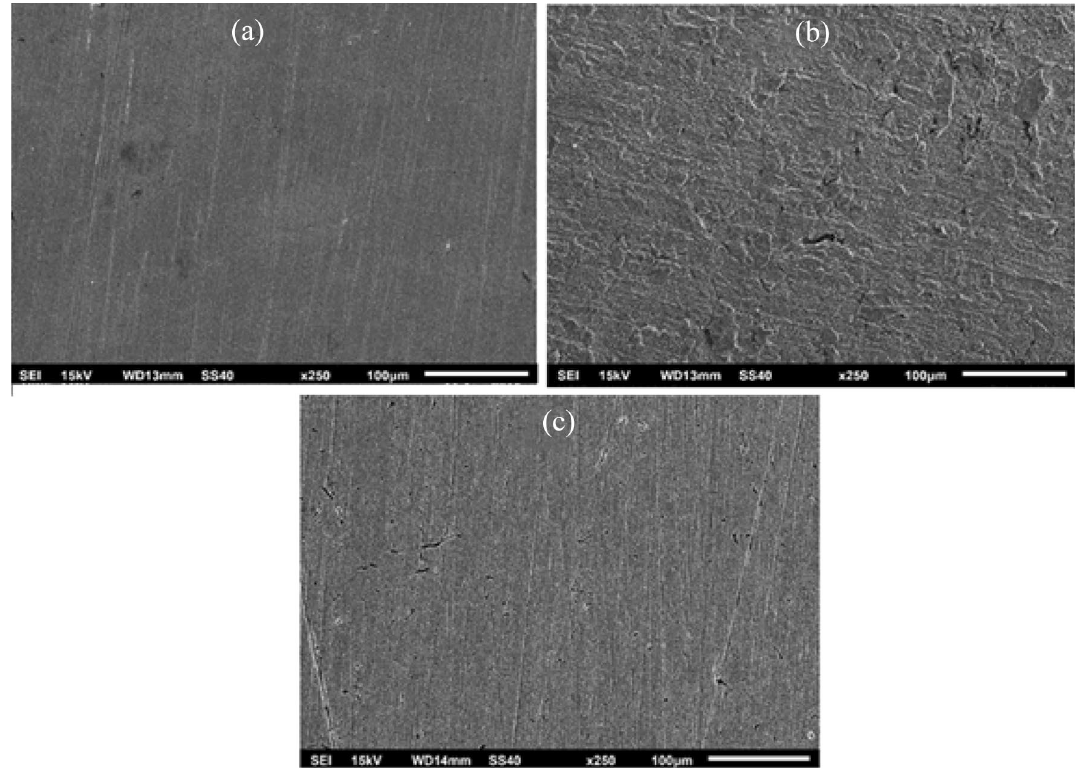
Figure 9. SEM micrographs of MS surface immersed in 5% HCl with ( a ) absence of inhibitor ( b ) presence of inhibitor.